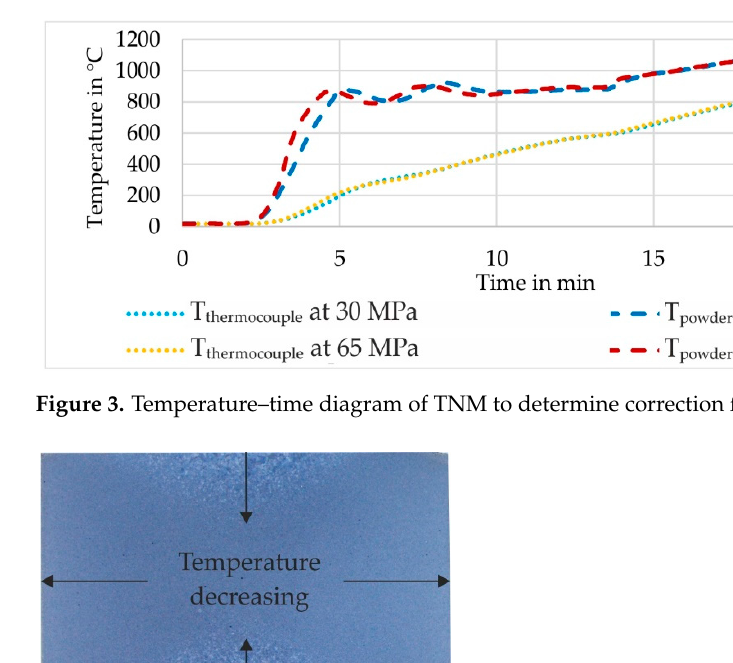
Figure 4. Stereographic image of sintered GE48 powder.